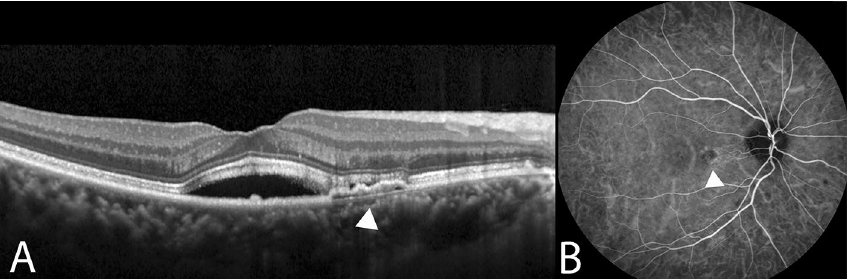
Figure 3. Multimodal imaging of the right eye of a 62-year-old woman with pachychoroid neovasculopathy and with a history of chronic central serous chorioretinopathy. ( A ) Enhanced-depth imaging optical coherence tomography (OCT) demonstrated shallow irregular RPE detachment (double-layer sign) (white arrowhead) with subretinal fluid. ( B ) Choroidal hyperpermeability was indicated as hyperfluorescence (white arrowhead) on the indocyanine green angiography (ICGA) in the early-mid